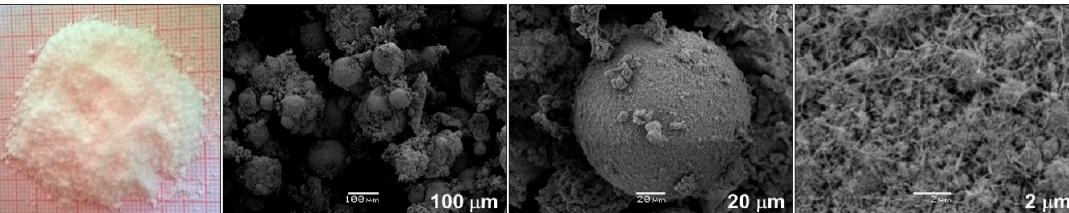
Figure 6. Photograph and SEM images at di ff erent magnifications of PUA powder prepared from Figure 6 . Photograph and SEM images at different magnifications of PUA powder prepared from Desmodur N3300 and water in propylene carbonate / hexane via suspension polymerization (monomer Desmodur N3300 and water in propylene carbonate/hexane via suspension polymerization concentration: 11% w / w). Scale lengths are indicated in the right-bottom corner of each (monomer concentration: 11% w/w). Scale lengths are indicated in the right-bottom corner of each frame.